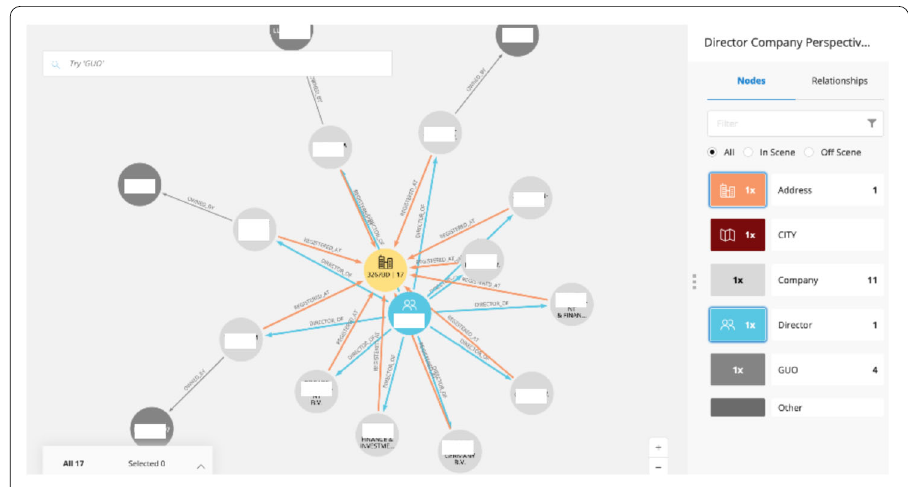
Figure 8 Example of a potential illegal CSP, visualized in Neo4J Bloom. Note that all companies (gray circles) are managed by the same director (blue circle), registered in the same address (yellow circle), and owned by different owners (dark gray circles). The director was afterward found in online